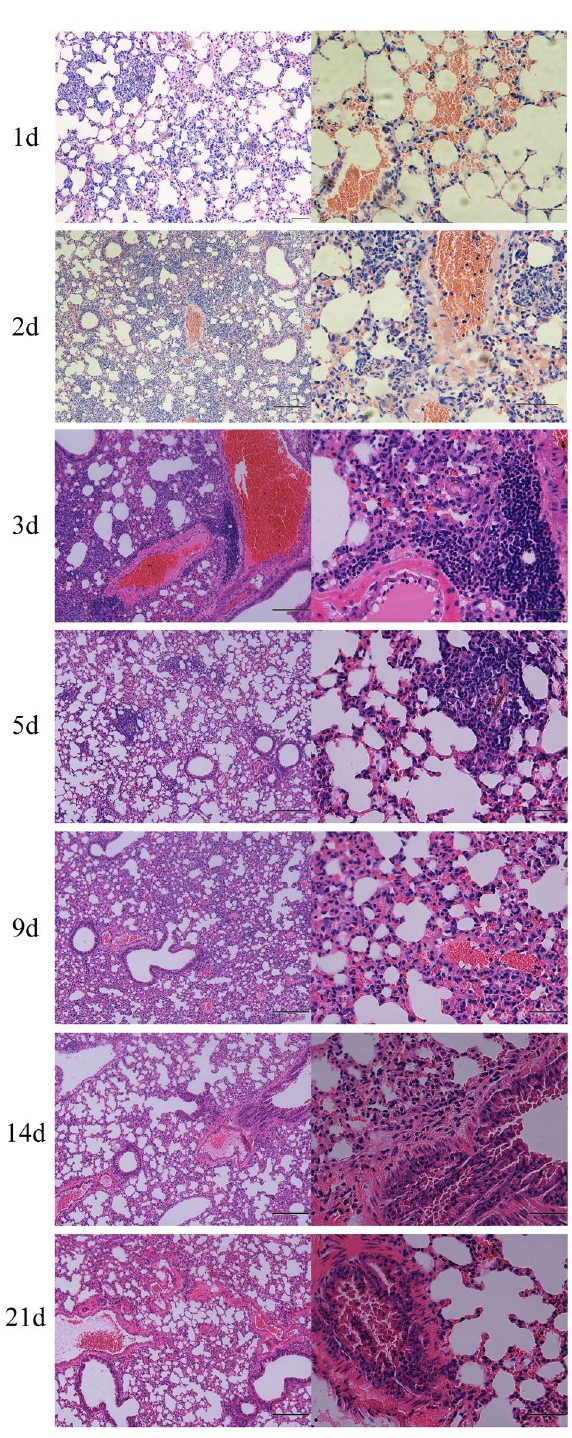
Figure 1. Histological assessment of lung lesions in mice intravenously infected with Cladosporium cladosporioides . Severe pulmonary hemorrhage and congestion were observed on days 1, 2, and 3 post- inoculation (PI), and extensive infiltration of inflammatory cells was observed throughout the infection period, especially around veins. Data are representative of three independent experiments (n = 3 mice per group). Scale bars, left-200 μm, right-50